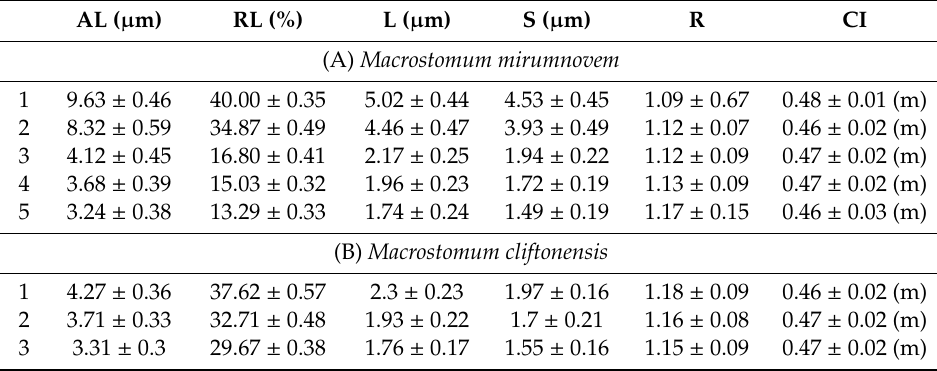
Table 2. Morphometric analysis of karyotypes of two newly analyzed Macrostomum species. ( A ) M. mirumnovem based on metaphase plates from worms with the 9, − MMI1 karyotype ( n = 50); ( B ) M. cliftonensis based on its 2 n = 6 metaphases ( n = 50). Reported values represent mean ± 1 SD and include the absolute length (AL) and relative length (RL) of each chromosome, the length of the long arm (L) and short arm (S) and the arm ratio (R = L / S), and the centromeric index (CI = S / (L + S)). m,